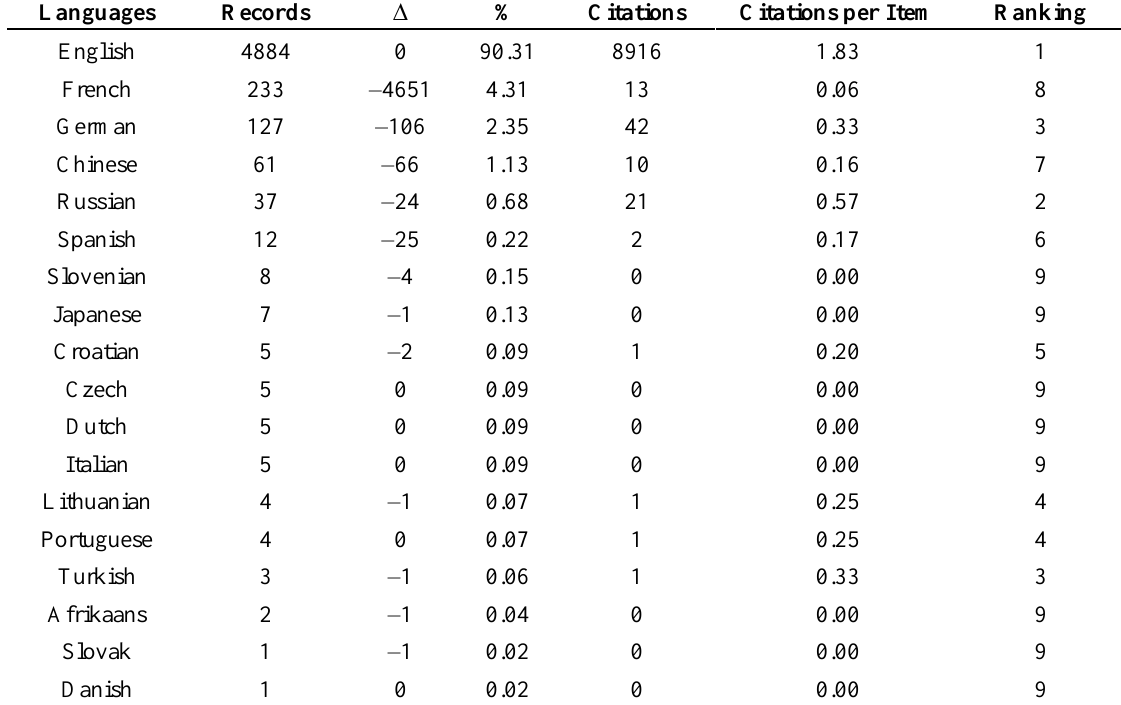
Table 2. Language-wise distribution and citation analysis of the 5407 indexed scholarly communications published in the field of Buddhism and Buddhist studies (1993–2011).